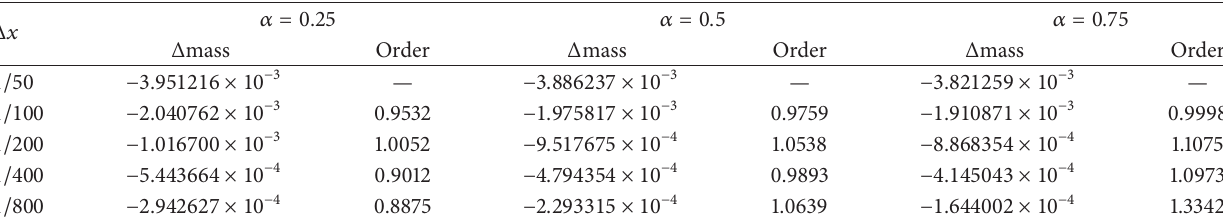
Figure 9: Schematics of computational domain (Case 4). Table 1: Conservation errors on GFM-based algorithm (Case